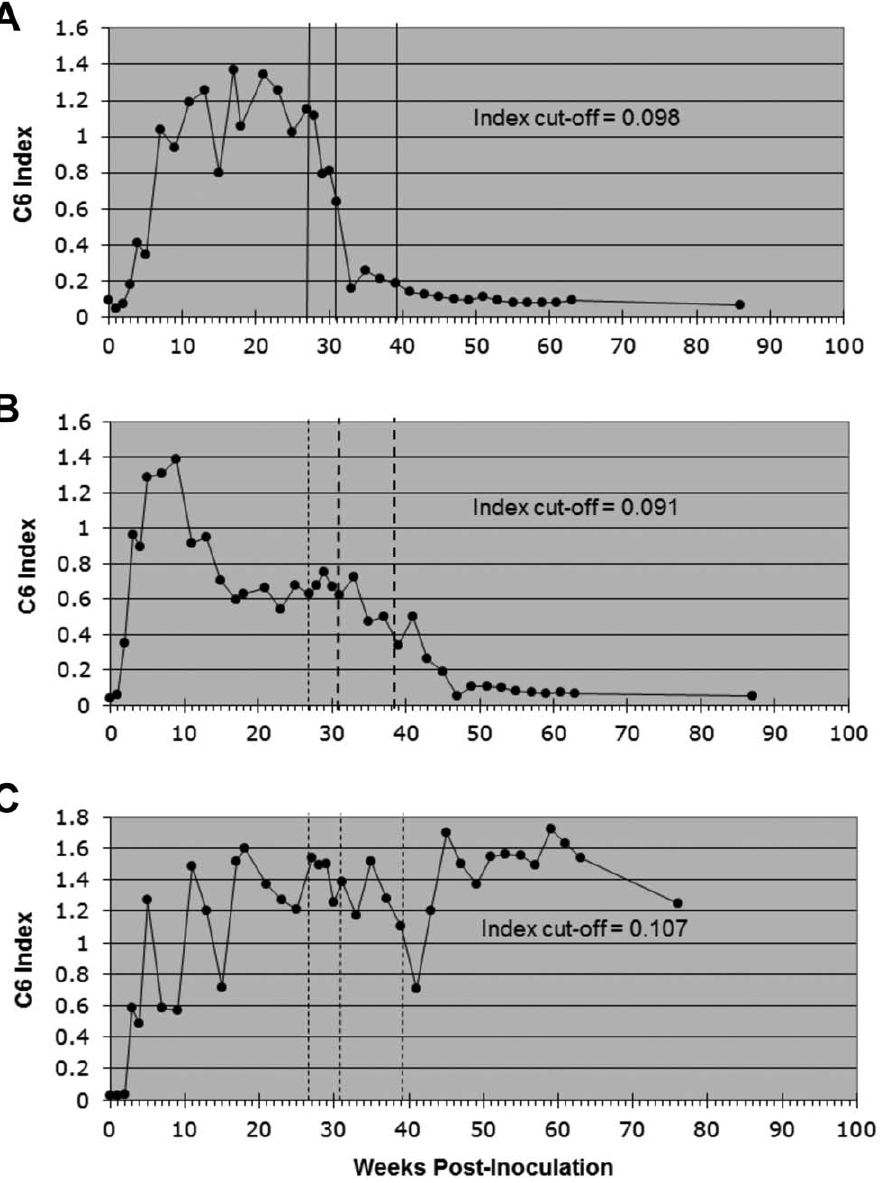
Figure 2. Patterns of antibody response to the C6 peptide in infected animals. The C6 index measured as a function of time PI with B. burgdorferi followed three distinct patterns in Experiment 1. Each graph is the longitudinal antibody response to C6 from one representative animal for each pattern. In treated (n=12) animals (A) the response declined sharply, almost to background levels, within the antibiotic administration periods (solid vertical lines, weeks 27–31 for ceftriaxone, weeks 31–39 for doxycycline). In sham-treated animals (B, C) the response either declined, but independently from the sham treatment intervals, to eventually reach background level (B, n=7), or oscillated throughout the study period without ever declining steadily (C, n=5). The pattern in (C) corresponds to the C6-positive animals, indicated in Table 1. The dotted lines in B and C indicate the sham-treatment intervals. The index cut-off value was calculated as described in Material and Methods.